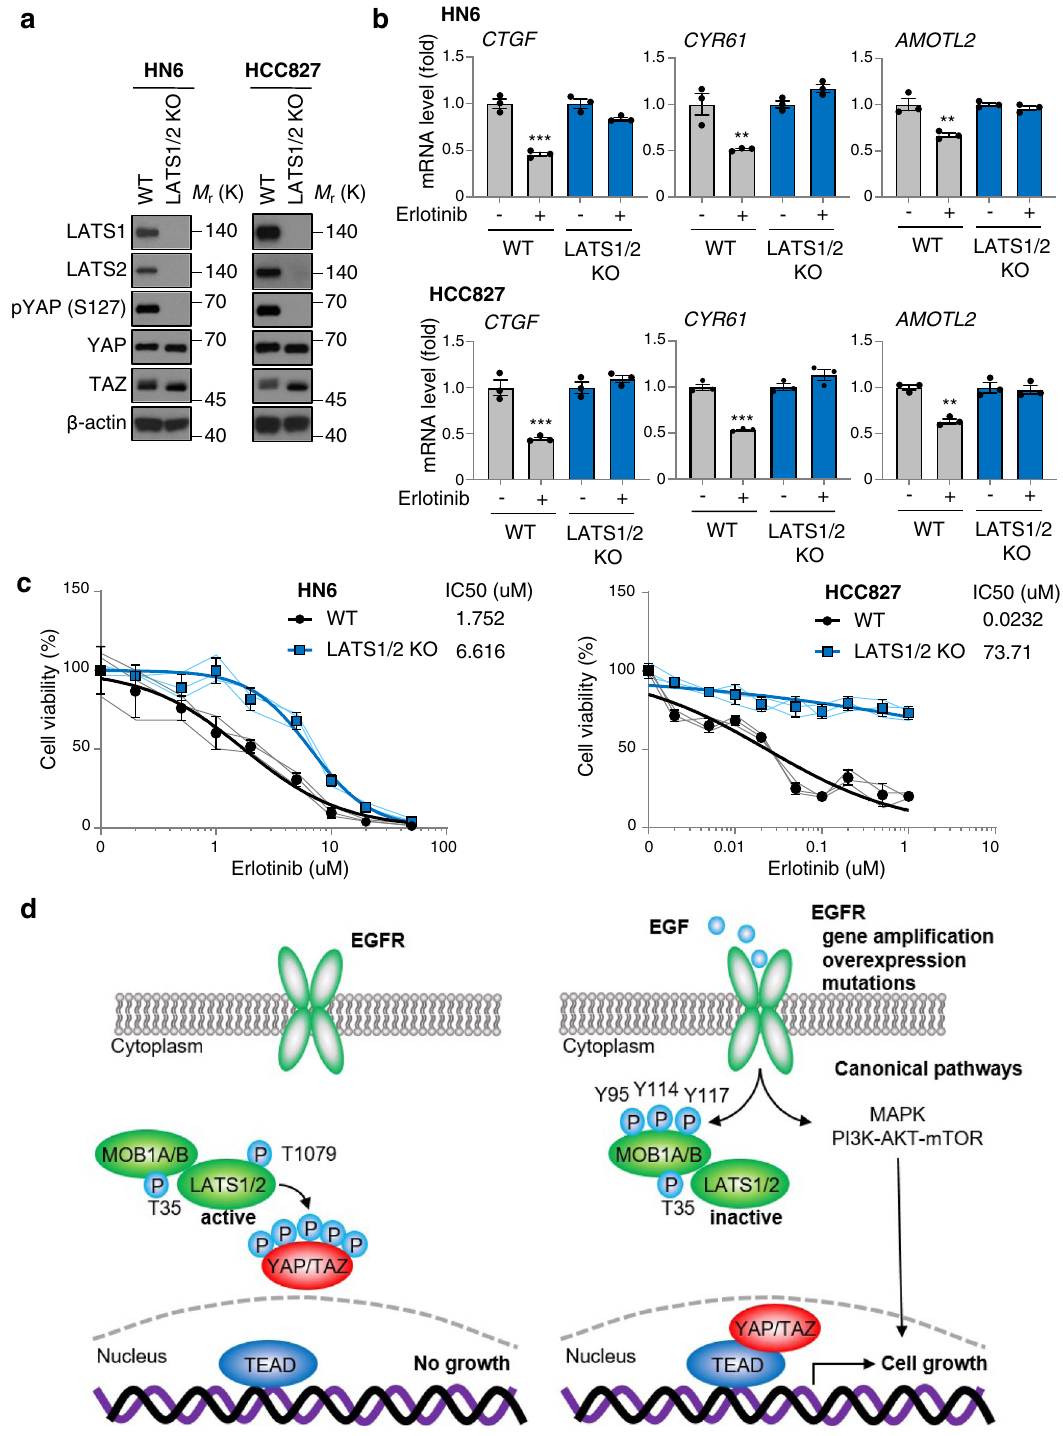
Fig. 6 Loss of LATS1/2 confers resistance to erlotinib treatment in cancer cells with EGFR alterations. a Immunoblot of LATS1, LATS2, pYAP (S127), YAP, TAZ, β -actin in WT or LATS1/2 KO HN6 and HCC827 cells. b Relative mRNA levels of CTGF , CYR61 , and AMOTL2 . Cells were treated with erlotinib (1 μ M) for 2 h. c Cell viability. Cells were treated with erlotinib for 3 days. d Schematic of EGFR-mediated YAP/TAZ activation. When EGFR is inactivated, the hydrophobic site of LATS1/2 is phosphorylated and LATS1/2 are active, leading to YAP/TAZ phosphorylation and cytoplasmic retention or degradation. Upon EGF stimulation or EGFR activation by gene ampli fi cation, overexpression or mutations, MOB1 is tyrosine phosphorylated and LATS1/2 are dephosphorylated and inactive, resulting in YAP/TAZ nuclear translocation and expression of growth promoting genes regulated by YAP/TAZ. ANOVA with Tukey – Kramer post hoc test were used. Mean ± SEM ( b ); *** P <0.001; ** P <0.01. *versus WT erlotinib